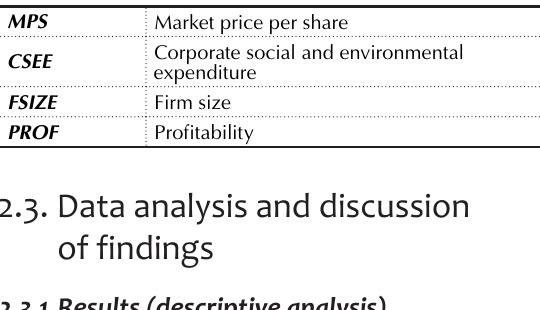
Table 2. Variable definition for this